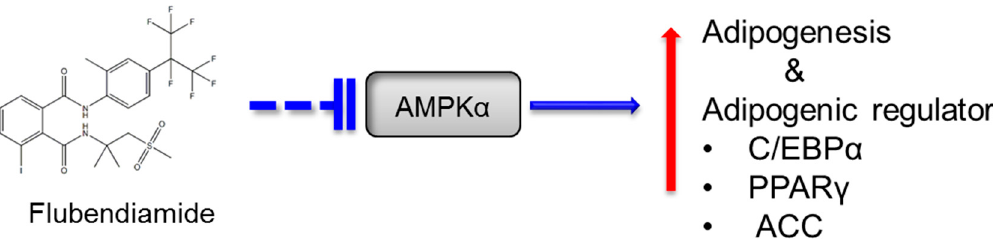
Figure 7. Flubendiamide promotes adipogenesis via inhibiting AMPK α . AMPK α , AMP-activated protein kinase- α ; C/EBP α : CAATT element binding protein- α ; PPAR- γ , peroxisome proliferator-activated receptor- γ ; ACC, acetyl-CoA